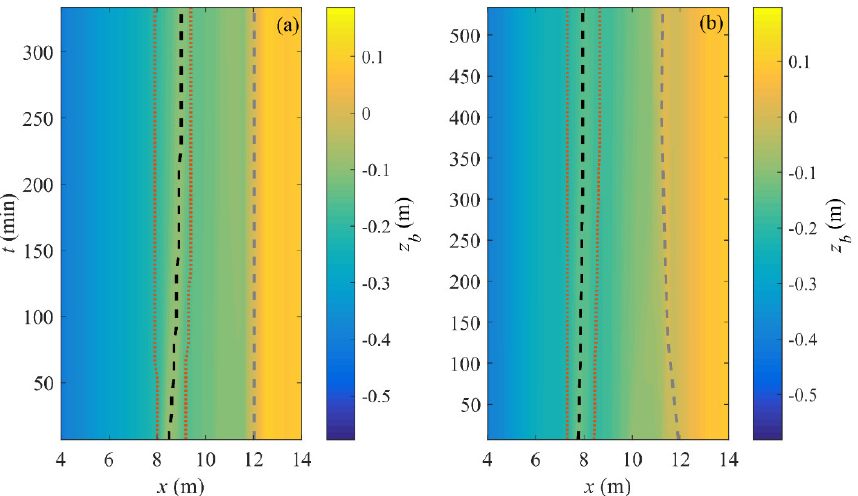
Figure 9. Spatiotemporal evolution of bed profile evolution for A1_2 ( a ) and E1_1 ( b ). Black dashed line means the crest of the nourishment and two dotted lines indicate two boundaries. Shoreline position is indicted by the grey dashed line.